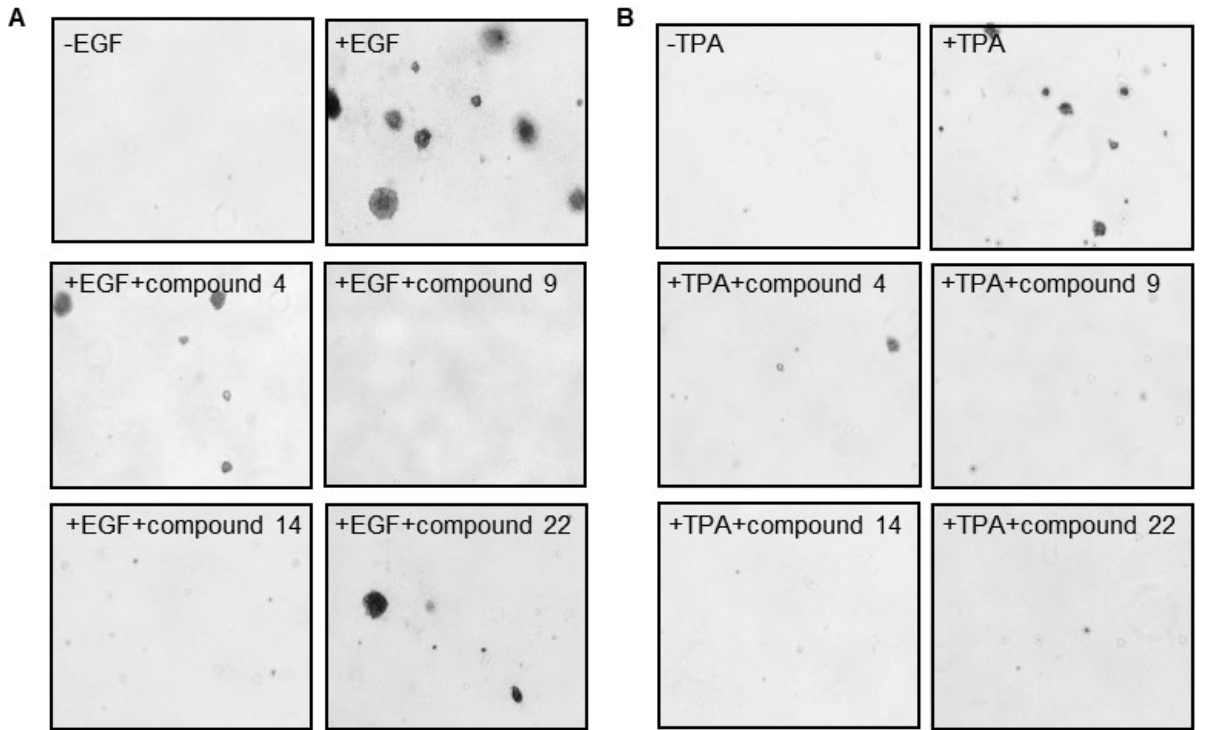
Figure 6. Effects of compounds on ( A ) EGF- or ( B ) TPA-induced cell transformation. Colony growth was assessed by soft agar assay in JB6 Cl41 cells. A and B depict representative images of colony growth in soft agar two weeks following treatment of DMSO, EGF-induced, or TPA-induced cells, respectively, with each of the four compounds. Table 3. Inhibitory activities of compounds on EGF- and TPA-induced cell transformation.